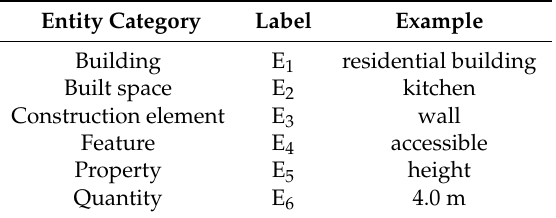
Table 1. Named entity